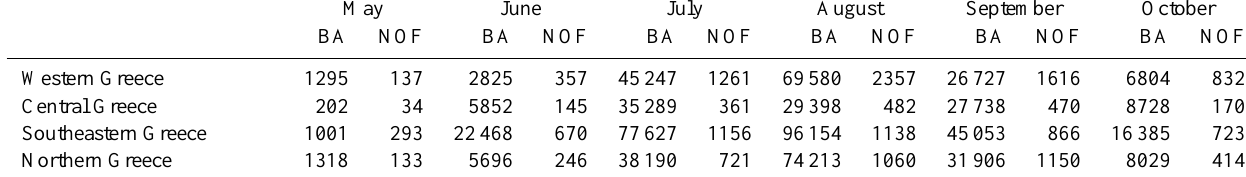
Table 1. Monthly burnt area (BA) in hectares and number of fire events (NOF) for the five sub-regions of the Greek domain for the period 1983–1997.